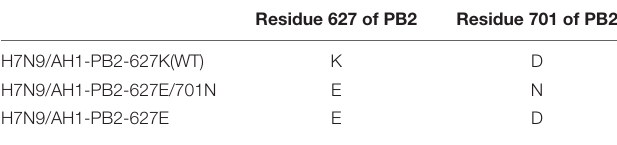
TABLE 1 | Amino acids at PB2 position 627 and 701 of viruses used in this